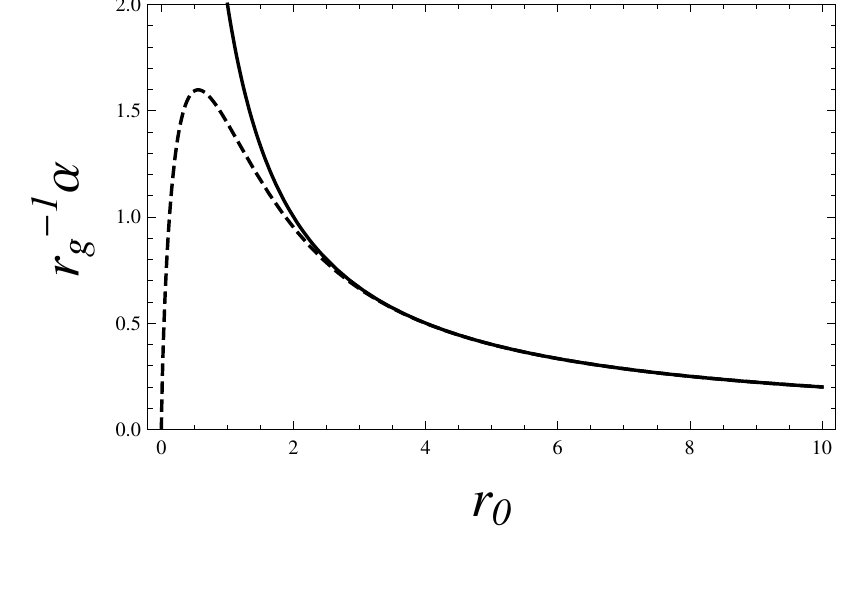
= 2 and any µ 2 1